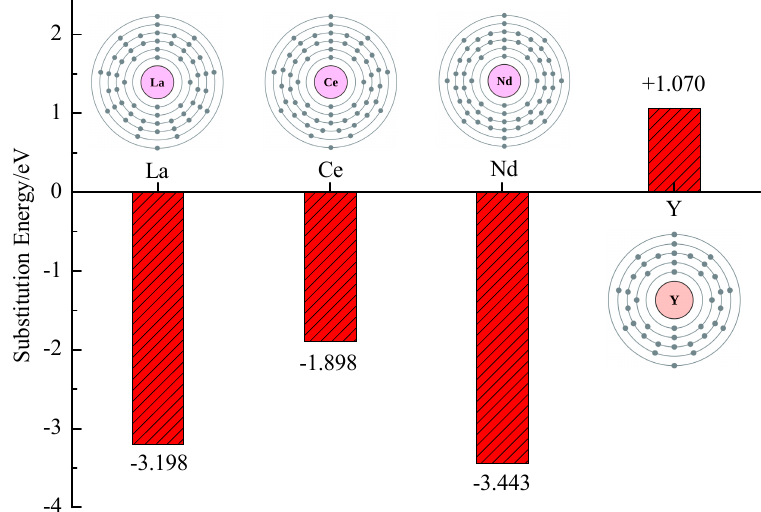
Figure 2. Substitution energies of REE atoms substituting for Ca atom.